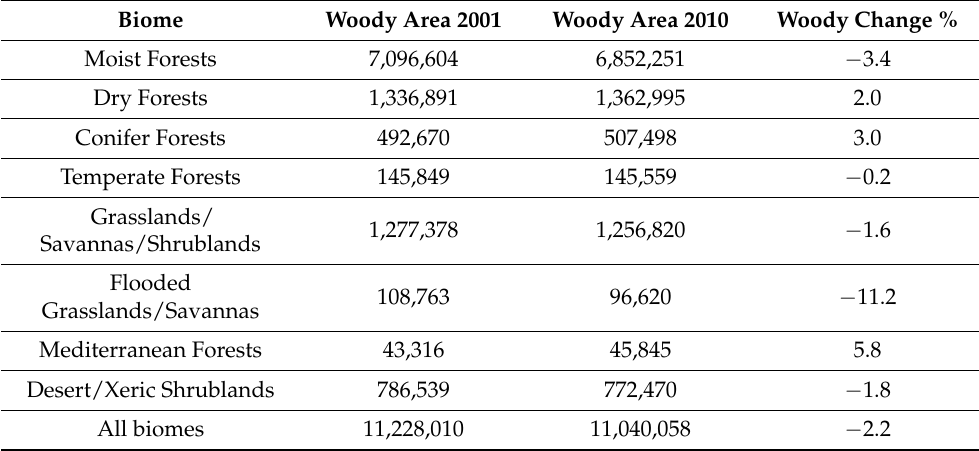
Figure 5. Estimated percent woody vegetation by ecoregion [32] for the year 2010. Table 4. Biome summary of estimated woody vegetation in years 2001 and 2010. Area data are in km 2